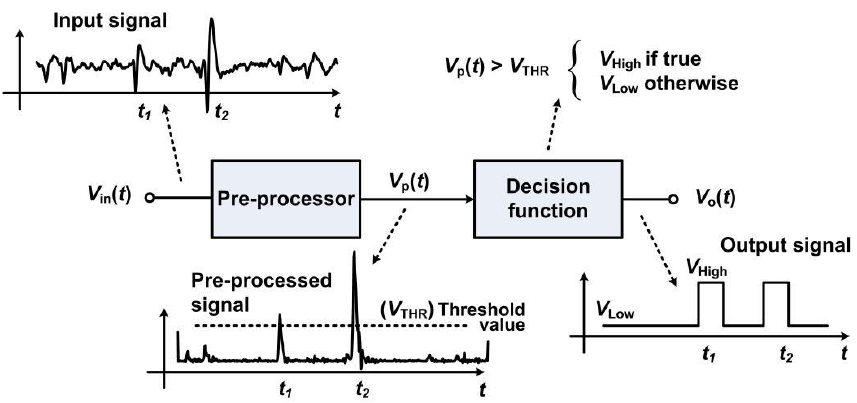
Figure 5. Block diagram of a signal detector employing a